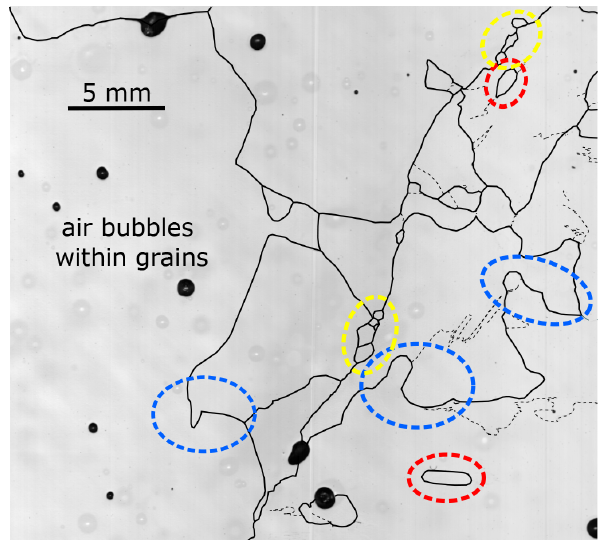
Figure 10. Example of a LASM image indicating several processes in the temperate ice: black areas are air bubbles; black lines rep- resent the grain boundaries; and dashed black lines indicate sub- grain boundaries. Air bubbles can be found completely trapped within individual large ice grains, indicating migration recrystalli- sation. Bulging of grain boundaries (blue circles), the development of island grains (red circles) and small grains along the boundaries of large grains (yellow circles) provide evidence for a dominating SIBM-N-type